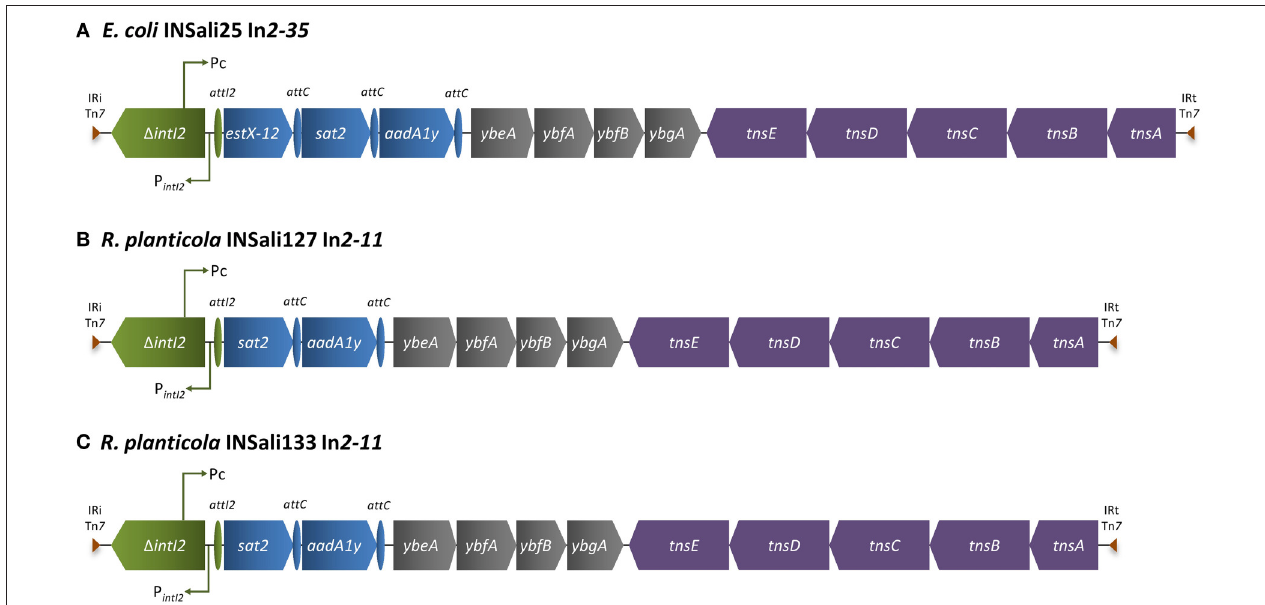
FIGURE 3 | Schematic representation of regions enclosing class 2 integrons detected among the bacterial population analyzed in the present survey ( n = 3/333). (A) E. coli INSali25 In 2–35 ; (B) R. planticola INSali127 In 2–11 ; (C) R. planticola INSali133 In 2–11 . Green, integron; blue, resistance genes, including gene cassettes; purple, transposons; gray, other